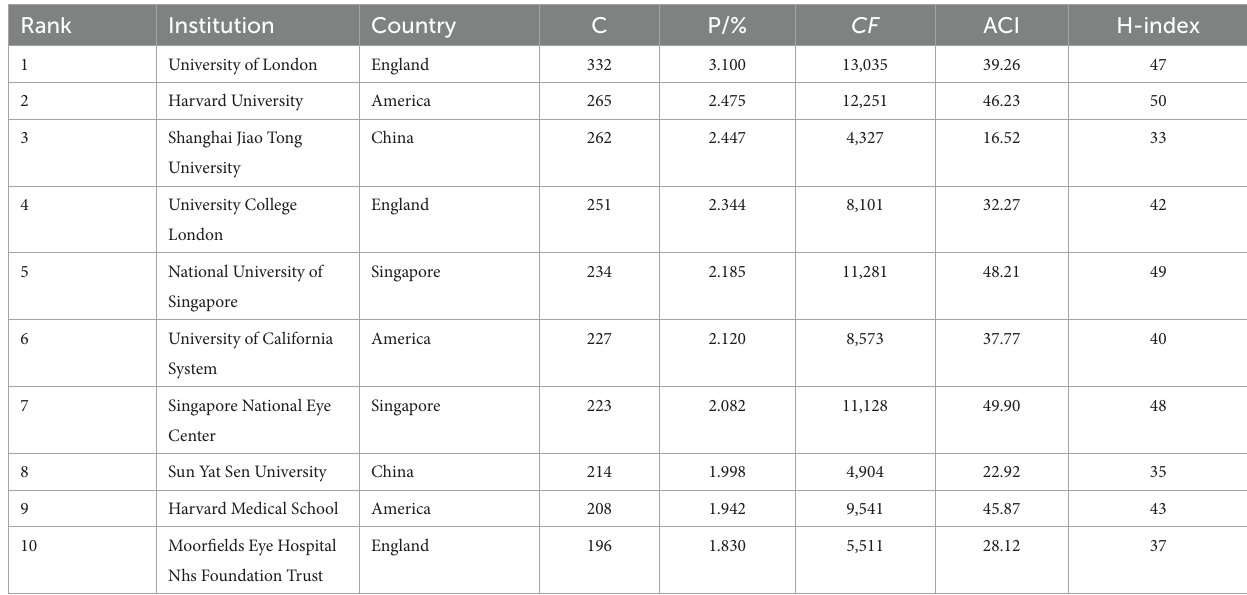
TABLE 2 Top 10 institutions by the volume of publication. Rank